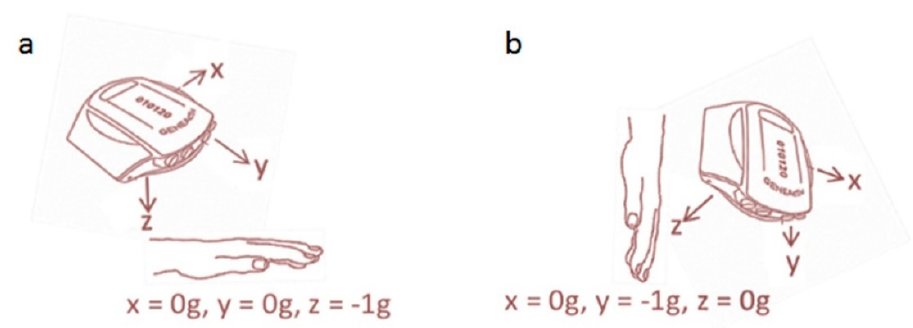
Figure 1. Orientation of the GENEA / GENEActiv axes when worn on the non-dominant wrist with the hand ( a ) level and ( b ) hanging